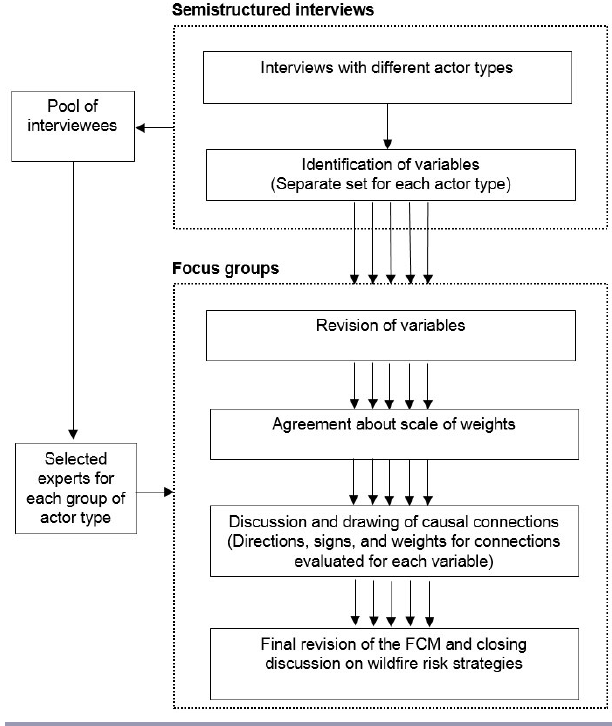
Fig. 2 . Steps implemented for the construction of fuzzy cognitive maps in focus groups. The five expert groups are represented by the five arrows in the flow diagram. The homogeneous focus groups are arranged by actor type: indigenous communities, private cattle ranchers, local authorities in Concepción, local authorities in Roboré, and regional experts. All actors are relevant to wildfire risk management in the Chiquitania